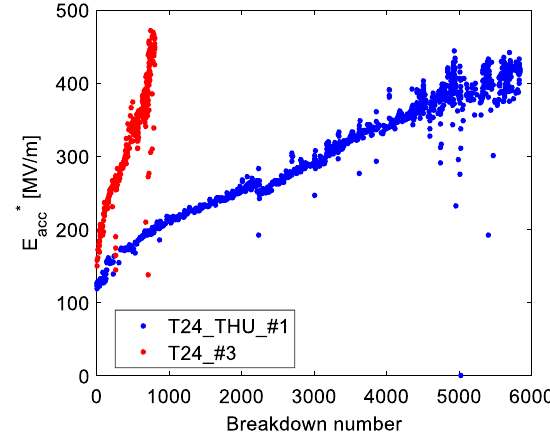
FIG. 16. Comparison of the normalized gradient versus the number of accumulated breakdowns for T24_THU_#1 and